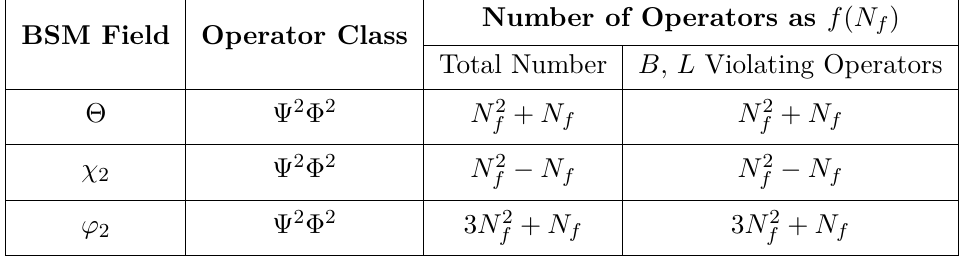
Table 41 . Number of additional operators of different classes at dimension 5 with N f fermion flavours, for the models containing χ 2 and ϕ 2